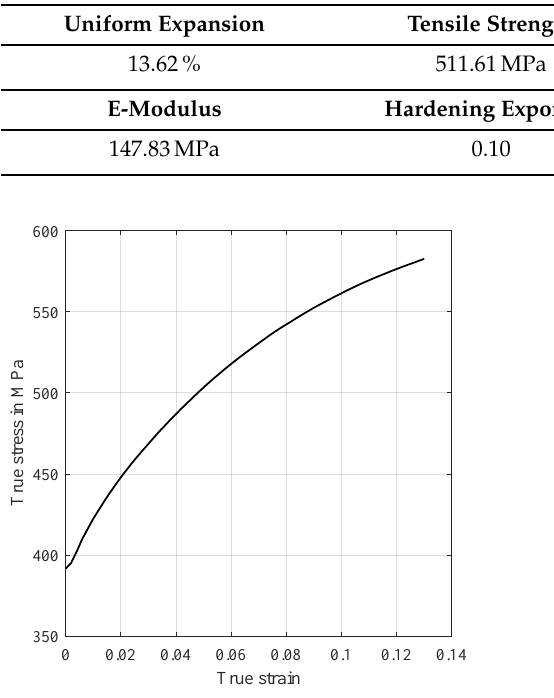
Table 6. Material properties of the examined non-oriented electrical steel Fe3.2wt.%Si.